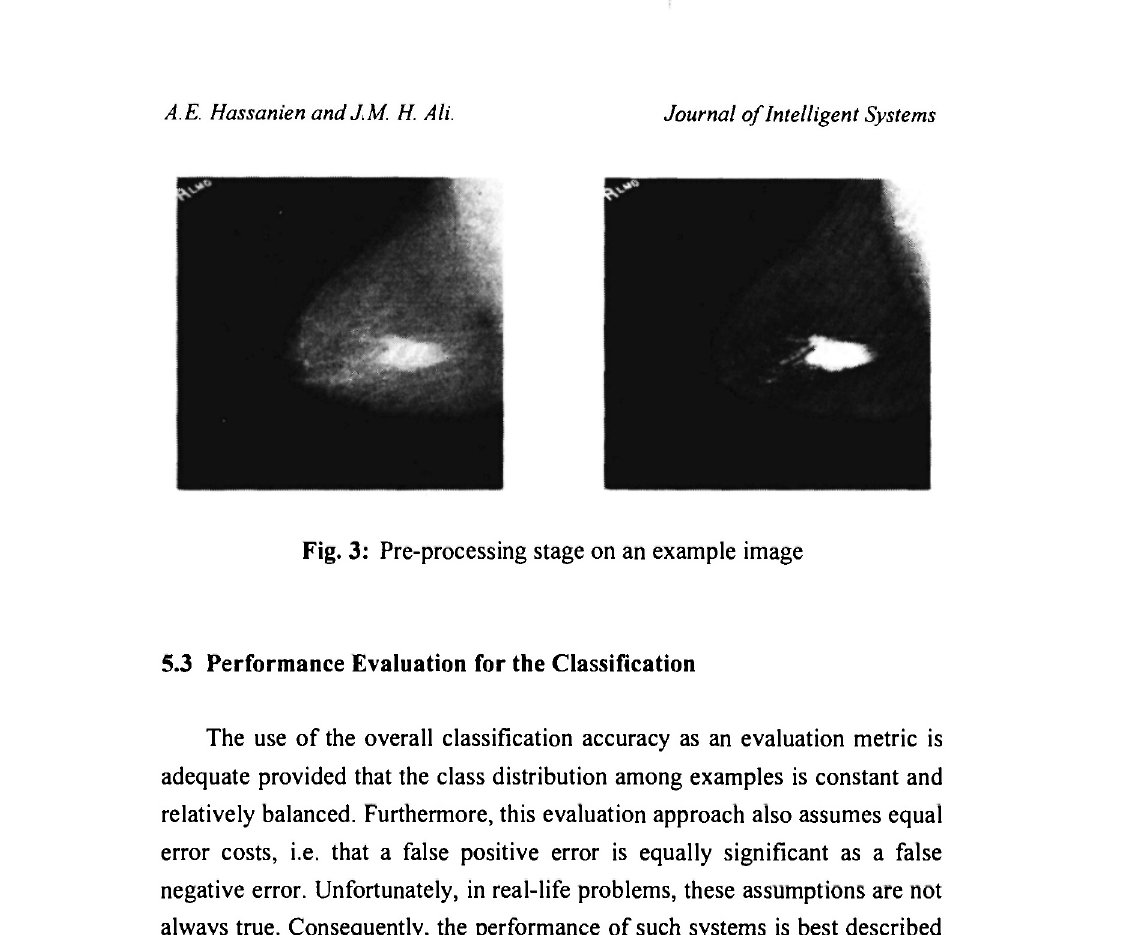
Fig. 3: Pre-processing stage on an example